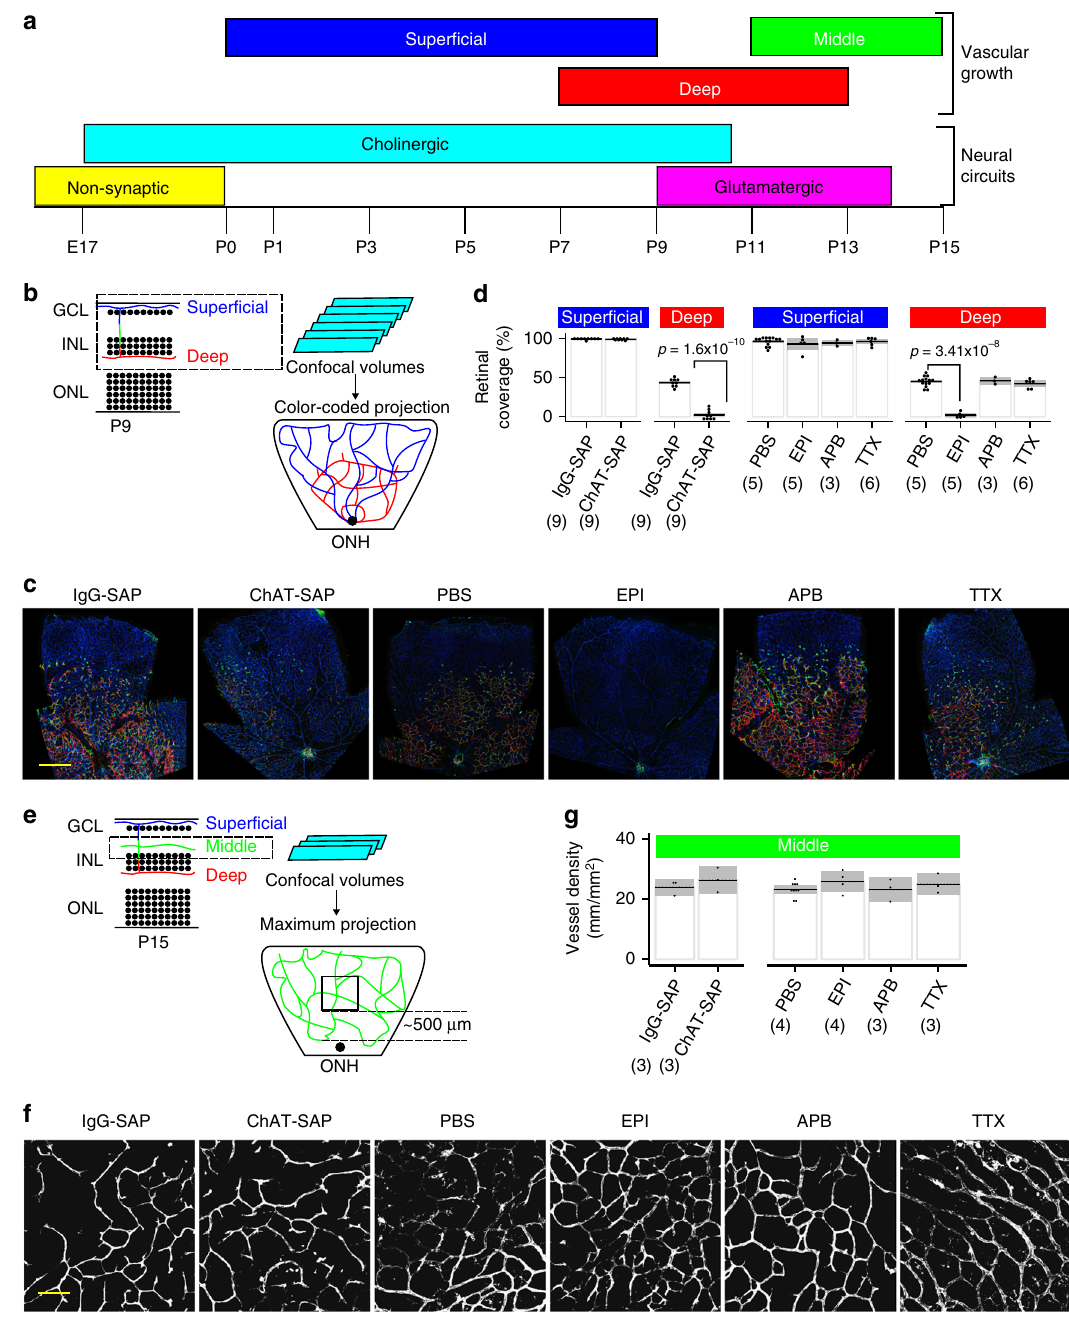
Fig. 1 Inhibition of SAC activity selectively inhibits deep vascular plexus formation. a Neural circuit-speci fi c activity overlaps with layer-speci fi c angiogenesis in the developing mouse retina. b Schematic of the confocal imaging strategy for BSL-stained retinas. Confocal stacks taken at P9 were color- coded for depth so that the super fi cial layer is blue, penetrating vessels are green, and deep-layer vessels are red. c Anti-ChAT-SAP was injected intravitreally at P3 and pharmacologic inhibitors (EPI, APB, and TTX) were injected intravitreally at P3, P5, and P7 and the retinas were analyzed at P9. Scale bar is 200 µ m. d The deep and super fi cial layers develop radially from the optic nerve head (ONH) and thus were quanti fi ed as the percentage of retinal surface area covered by each vascular layer. EPI and ChAT-SAP injected retinas both demonstrate a lack of deep-layer vasculature not observed in APB- or TTX-injected eyes or in control eyes (IgG-SAP and PBS). e Schematic of the strategy for isolating the middle layer by confocal imaging of BSL-stained retinas at P15. f Anti-ChAT-SAP was injected intravitreally at P11 and pharmacologic inhibitors (EPI, APB, and TTX) were injected intravitreally at P11 and P13, and the retinas were analyzed at P15. g The middle vascular layer develops contemporaneously at all retinal eccentricites, and thus was quanti fi ed by sampling an area near the ONH and measuring the linear amount of vessels in the middle layer per unit area of retina. None of the injected compounds had any effect on middle layer development. Scale bar is 50 µ m. Statistical tests are Student ’ s t tests, two-tailed, paired when comparing control and treated eyes from the same animal, otherwise assuming unequal variances. In d , g , individual data points are plotted, dashed line is the mean, gray box is the 95% con fi dence interval, number of retinas analyzed is in parentheses, and all other comparisons were not signi fi cant. Number of independent samples in each group is in parentheses under the X -axis data label. Bandeiraea simplicifolia lectin I (BSL) staining was used to visualize